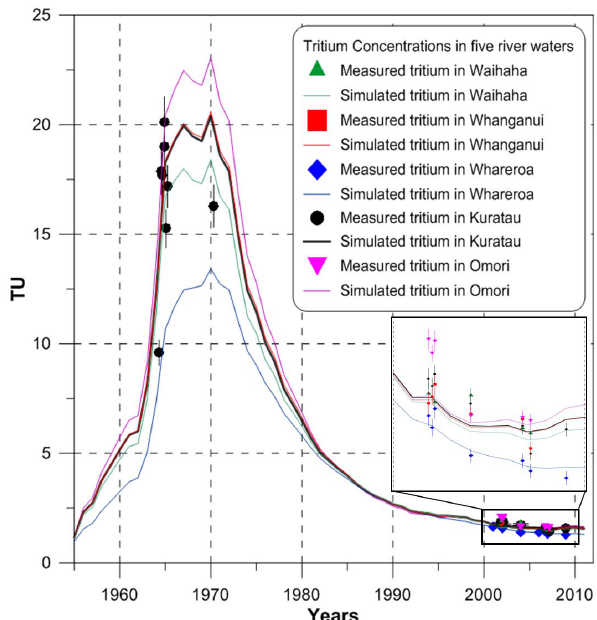
Fig. 4. Simulated and measured tritium concentrations with the MT3DMS transport model for Waihaha River, Whanganui Stream, Whareroa Stream, Kuratau and Omori rivers of the western Lake Taupo catchment. The zoom-in box is between 1.2 and 2.2